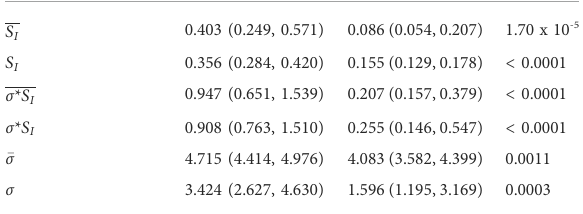
TABLE 4 Data assimilation-derived mechanistic model parameter estimate comparisons by binary post-operative outcome at 12 months. The parameters S I , σ , and σ *S I refer to the means of the posterior distributions for each patient. Overlined parameters were estimated without insulin values. For comparisons, medians and 95% con fi dence intervals of the median are shown. All comparisons had signi fi cant p -values for Mann-Whitney-U test after Bonferroni correction ( p <